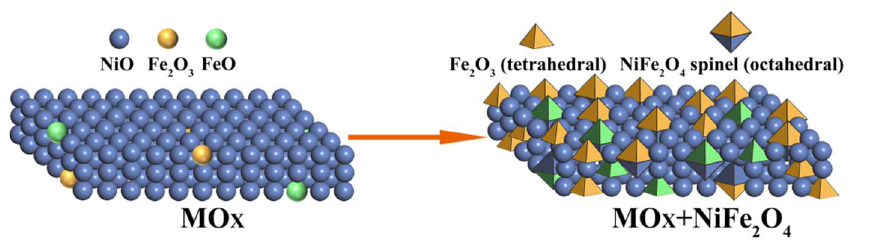
Figure 6. The ideal model of catalysts with MO x (M = Ni or Fe) or multiple phases (MO x and a NiFe 2 O 4 spinel).